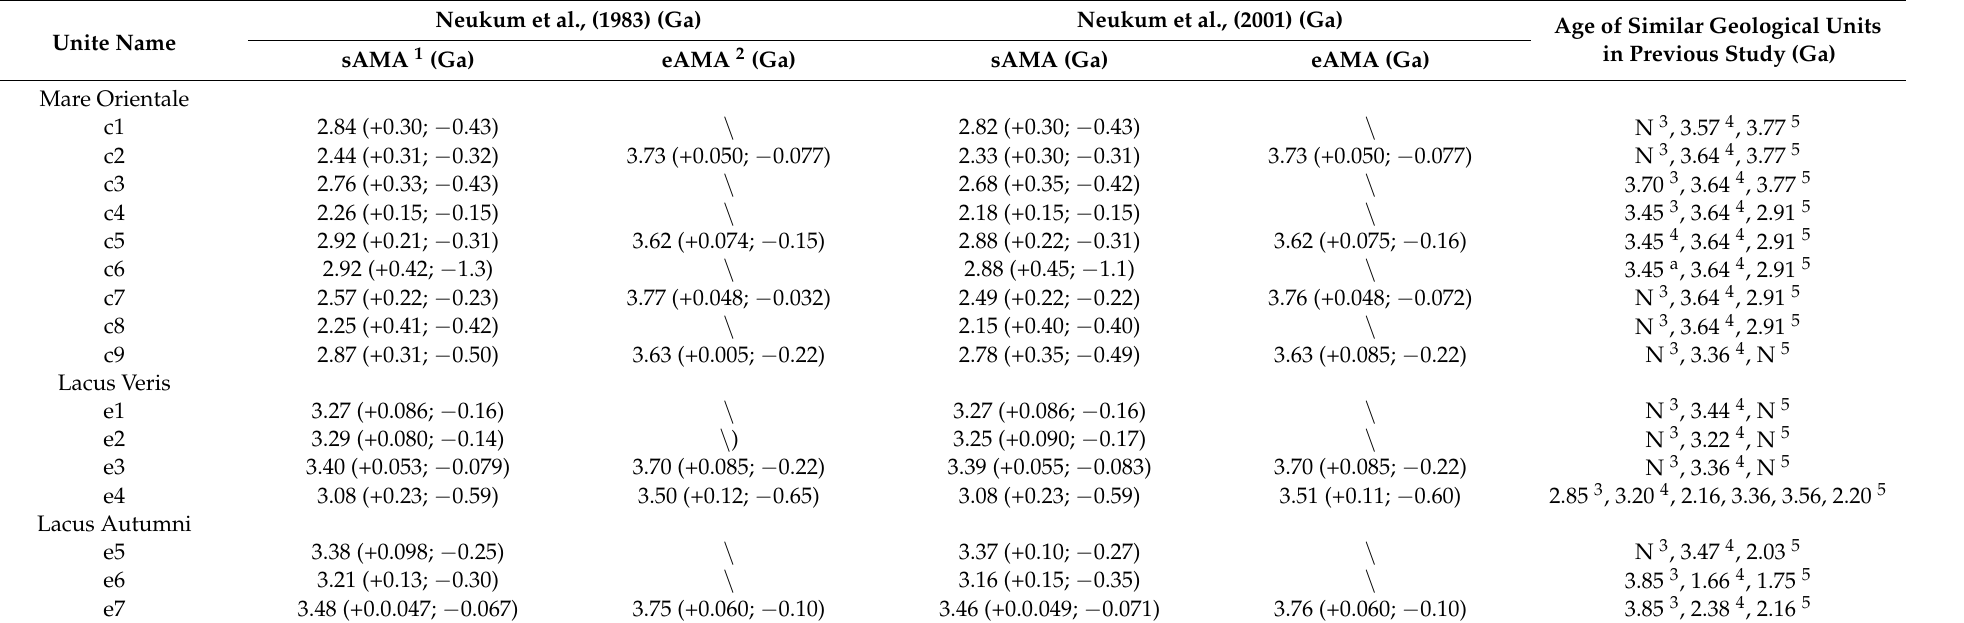
Table 2. Model ages of the basalts in Orientale